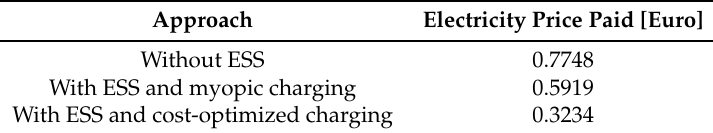
Table 2. Price comparison between different approaches for Scenario 1.